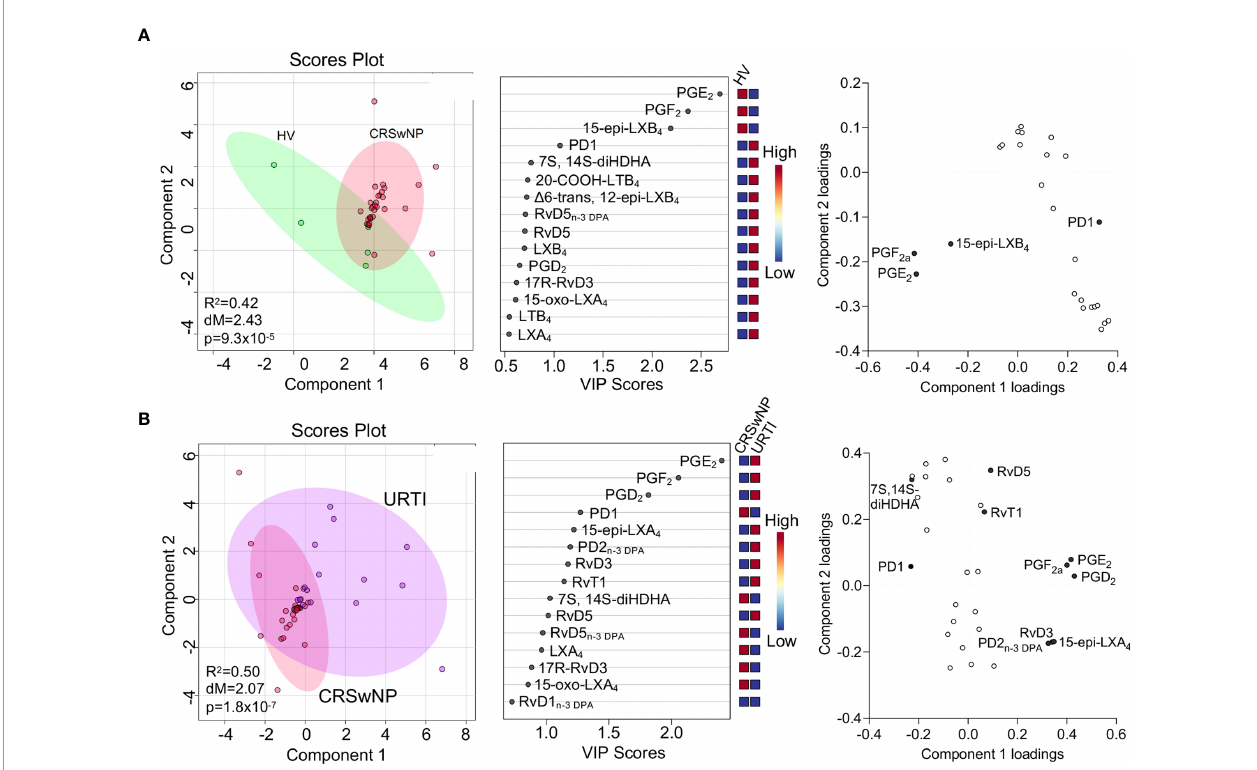
FIGURE 4 | Nasal secretions from patients with CRSwNP display a distinct LM pro fi le to those from both healthy volunteers and URTI patients. (A) Nasal secretions were collected from patients with CRSwNP (n = 16) and healthy volunteers (HV, n = 5) LM concentrations were determined using LC-MS/MS based LM pro fi ling (see methods for details). Differences in LM concentrations were evaluated using PLS-DA. ( Left panel ) 2-dimensional scores plot and ( centre panel ) corresponding VIP plot of plasma LM ( right panel ) loading plot where mediators with VIP score >1 are annotated. (B) Nasal secretions were collected from patients with CRSwNP (n = 16) and patients with URTI (n = 8) LM concentrations were determined using LC-MS/MS based LM pro fi ling (see methods for details). Differences in LM concentrations were evaluated using PLS-DA. ( Left panel ) 2-dimensional scores plot and ( centre panel ) corresponding VIP plot of plasma LM ( right panel ) loading plot where mediators with VIP score >1 are annotated. Shaded areas represent 95% con fi dence interval (CI), R 2 = coef fi cient-of-determination, p = p-value from Hotelling ’ s T-squared test, dM = Mahalanobis distance between